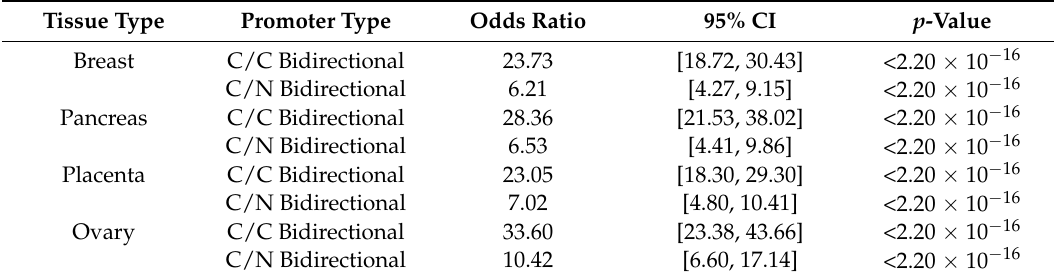
Table 3. Enrichment of bidirectional vs. single gene promoters for DNAse hypersensitive sites.